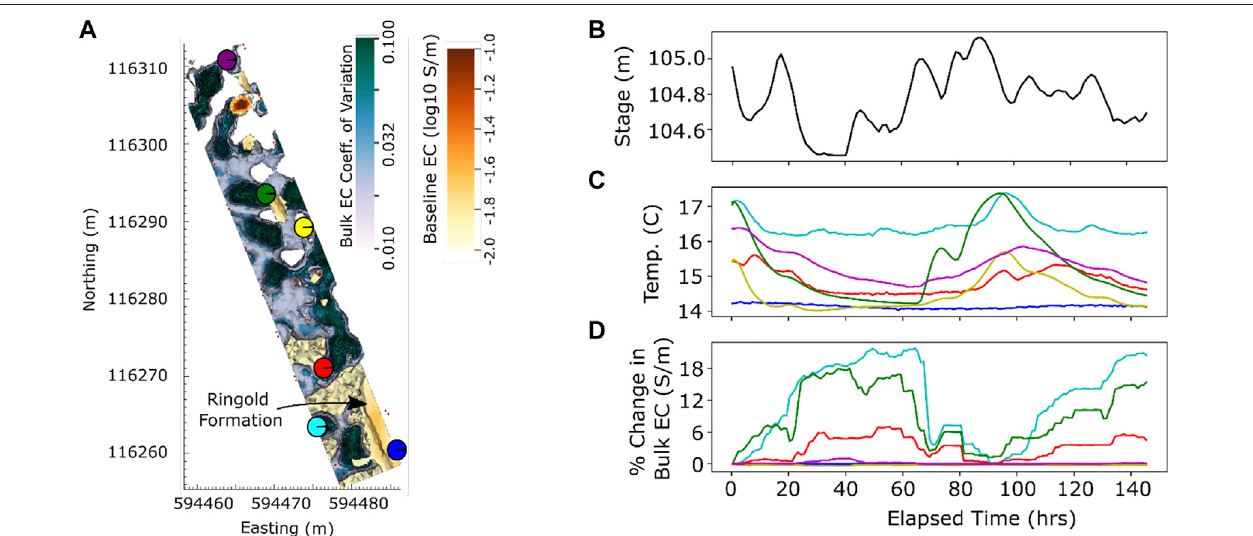
FIGURE8|(A) PlanviewofbulkECcoef fi cientofvariationrepresentedby3Disosurfaces.Sixdotsrepresentcolorsandlocations(~50 cmbeneaththeriverbed)of temperatureandbulkECtime-seriesshownin (C) and (D) . (B) Riverstageelevationtimeseries. (C) Temperaturetimeseriesatthelocationsshownin (A) Riverwaterand